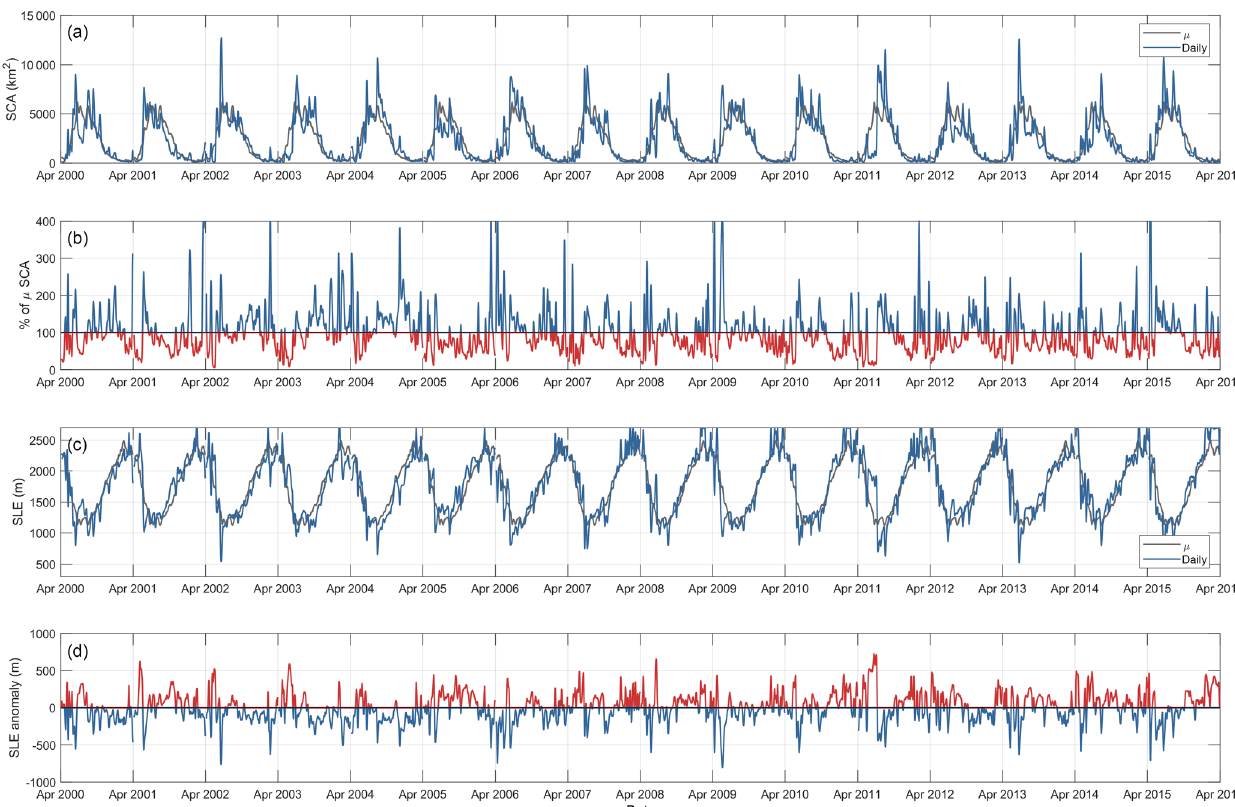
Figure 8. A 5d moving average of daily snow-covered area (SCA) and percentage of mean snow-covered area for all years (a, b) , and daily snowline elevation (SLE) and daily SLE anomaly (c, d) . Mean daily values, repeated for each year, are shown in grey in the daily SCA and SLE